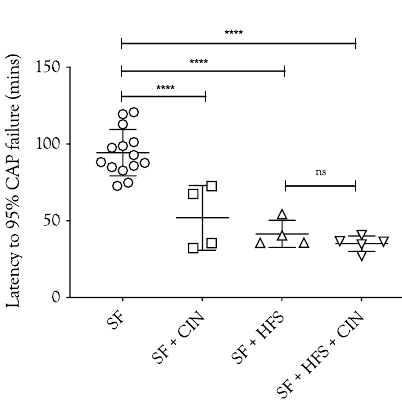
Figure 1. A fibre CAP conduction in substrate-free (SF) aCSF. ( A ). Specimen records of ex vivo sciatic nerves stimulated electrically, showing the fast-conducting A fibre CAP and the slow-conducting C fibre CAP. Stimulation was adjusted to elicit a maximal A fibre CAP amplitude. The behaviour of the low-amplitude C fibre CAP was not evaluated further. Scale bars are 5 ms and 2 mV for the A fibre CAP and 2 ms and 10 µ V for the C fibre CAP. ( B ). Perfusing sciatic nerves with substrate-free (SF) aCSF resulted in a slow reduction in A fibre CAP amplitude. The speed of failure was accelerated by adding 200 µ M cinnamate (CIN), high-frequency stimulation (HFS), or both. ( C ). In substrate-free conditions, the A fibre CAP was maintained for 94.3 ± 15.1 min ( n = 14), which fell to 51.9 ± 21 min ( n = 4) on addition of CIN, 41.5 ± 8.8 min, ( n = 4) on exposure to high-frequency stimulus, and 35.1 ± 5 min ( n = 5) with both CIN and high-frequency stimulus. (G = glucose, L = lactate, HFS = high-frequency stimulus, CIN = cinnemate: applies to all figures; **** = p ≤ 0.0001, ns = not significant).